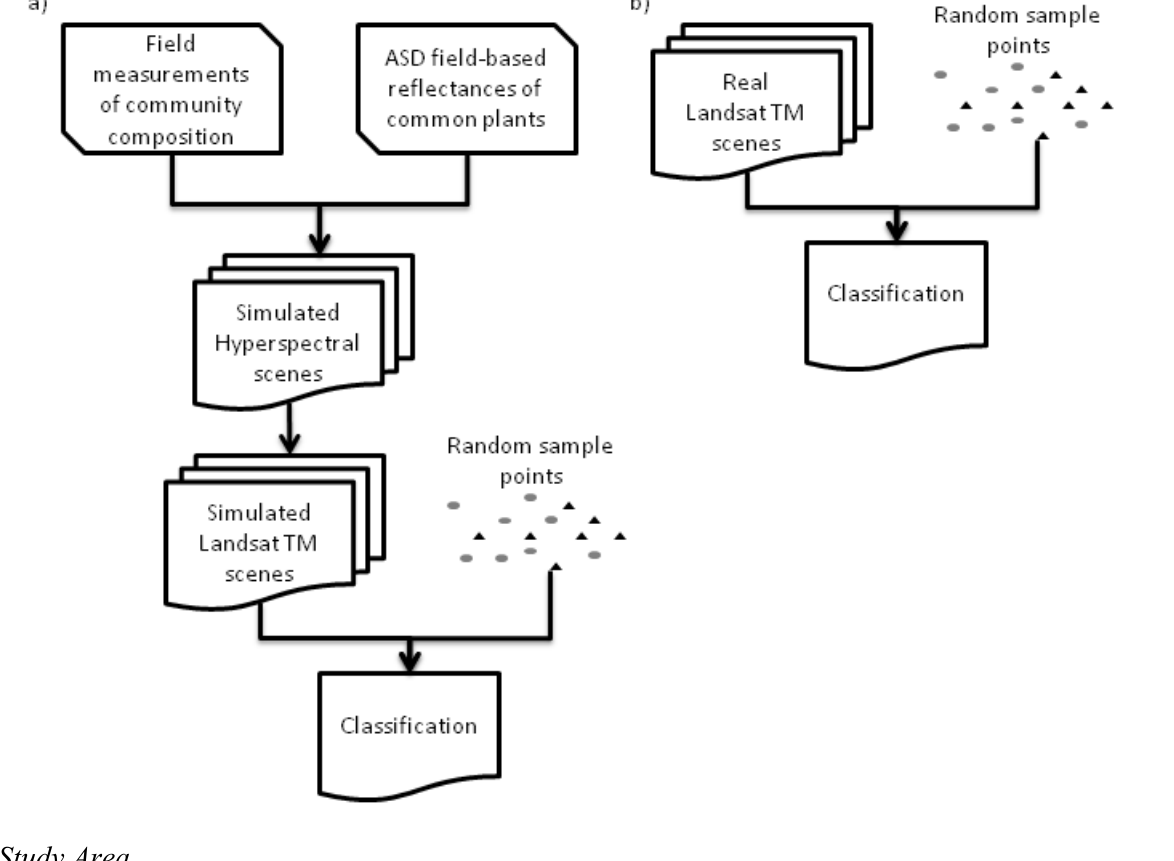
Figure 2. Flow diagram indicates the source of simulated and real Landsat TM scenes and classification